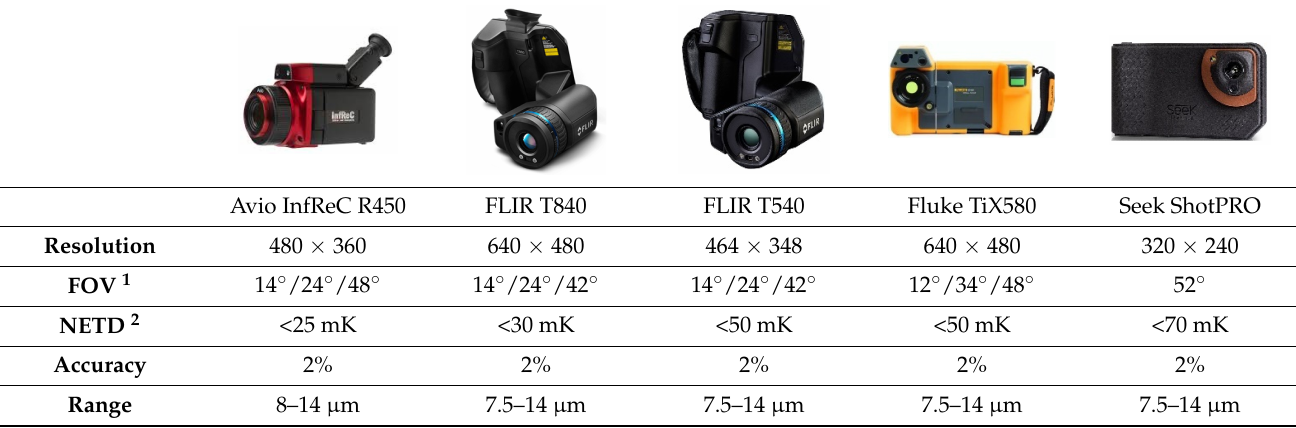
Table 2. Thermal cameras for building